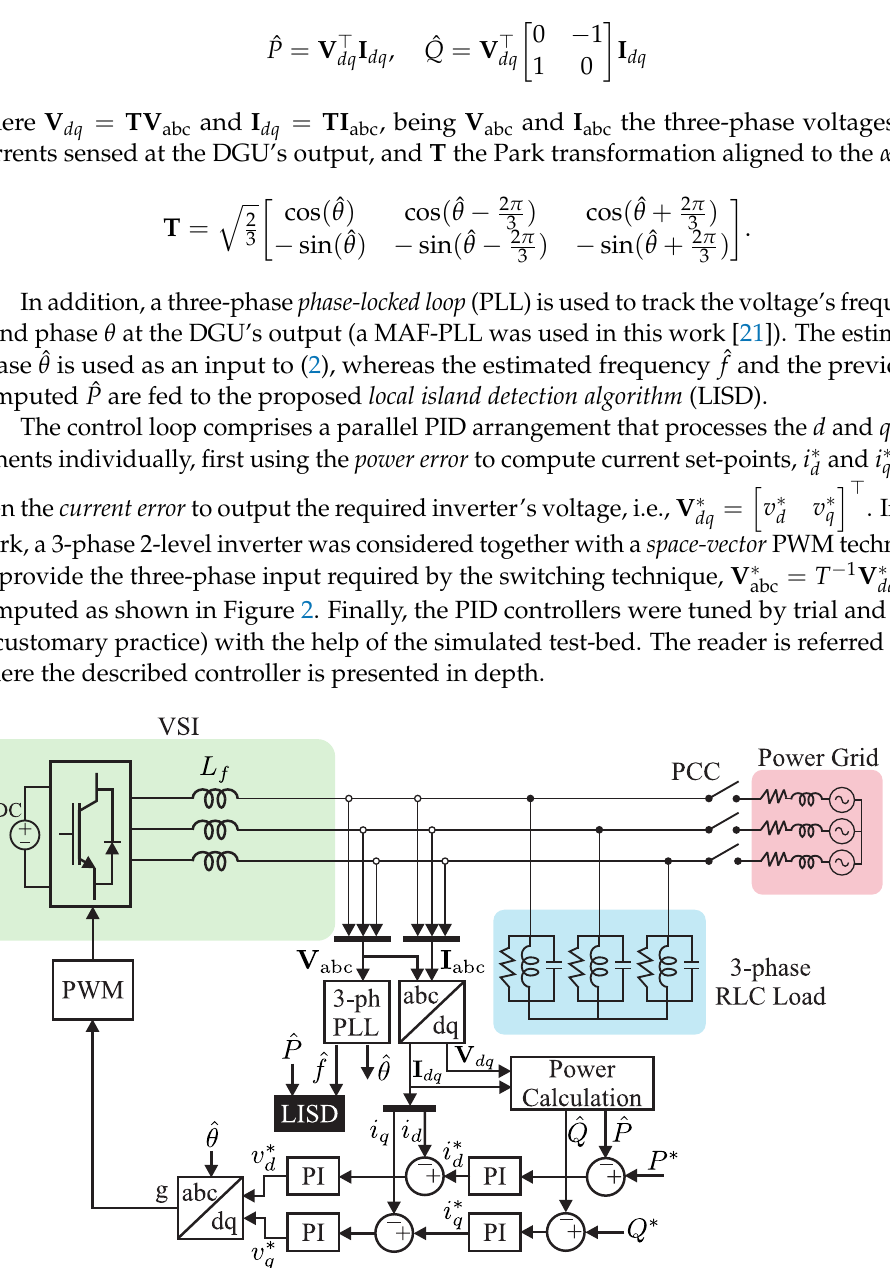
Figure 2. Control block scheme for interfaced DGU and proposed